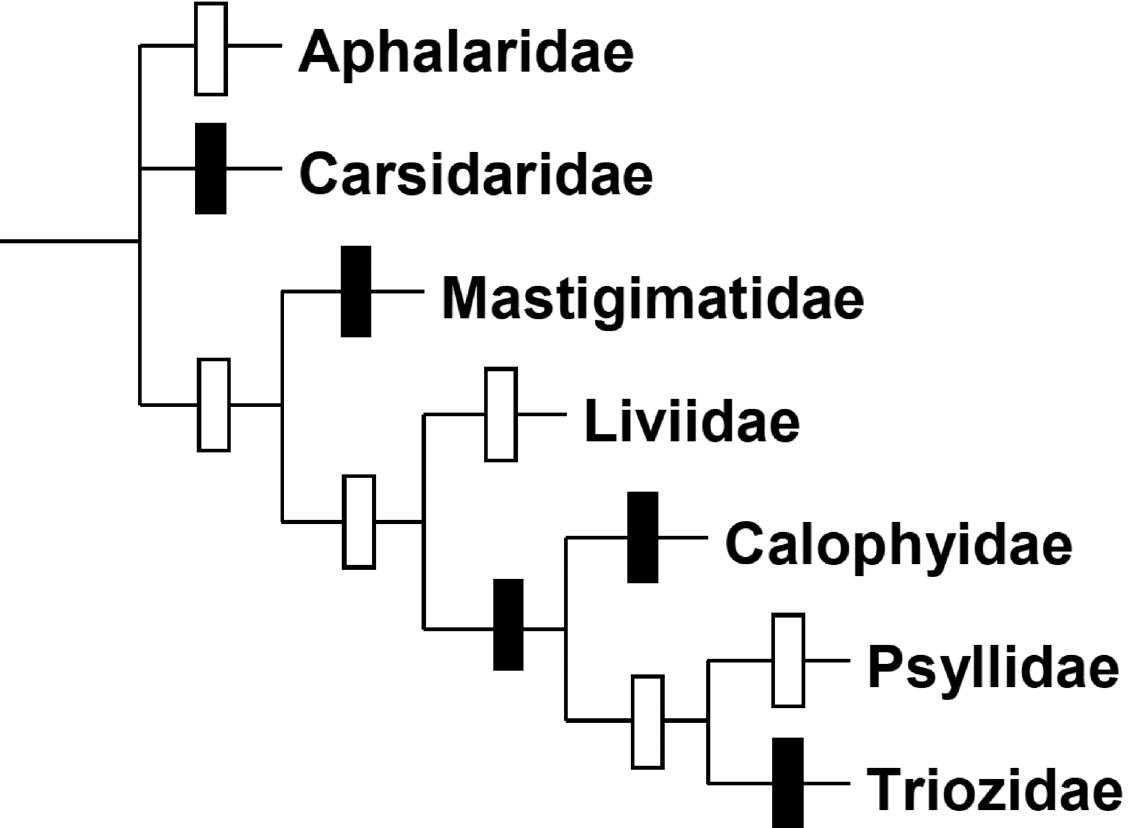
Fig. 1. Cladogram representation of the classification of Psylloidea Latreille, 1807 adopted here, node symbols indicate families with poor to moderate support (white), or strong support (black) in molecular analyses (Percy et al .